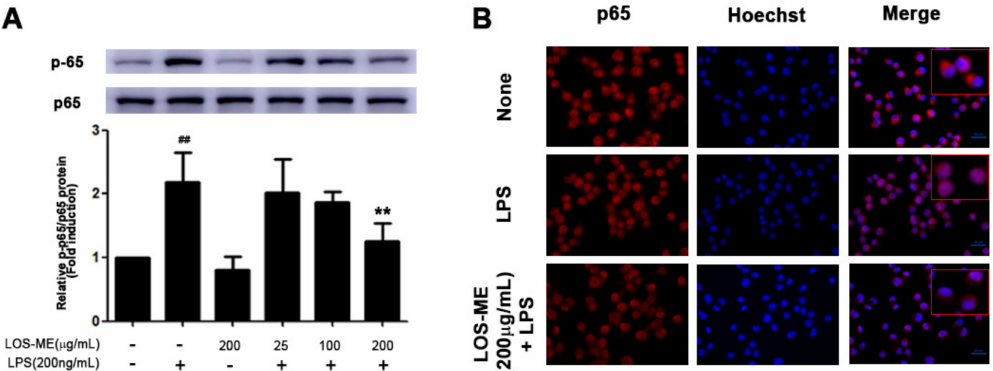
Figure 4. Effect of LOS-ME on NF- κ B p65 phosphorylation in LPS-activated BV2 cells. BV2 microglia cells were treated with LOS-ME (200 µ g/mL) and LPS (200 ng/mL) for 30 min and confirmed by Western blot. ( A ) protein expression of p65 and p-p65 with corresponding fold change. ( B ) BV2 microglia cells were treated with LOS-ME (200 µ g/mL) and LPS (200 ng/mL) for 30 min and confirmed by ICC assay. Translocation of p65 protein was determined using an anti-p65 antibody and Alexa Fluor 568-labeled goat anti-mice antibody on immunofluorescence. Data are presented as mean ± SD ( n = 3). ## p < 0.01 compared with control group, ** p < 0.01 compared with LPS group by one-way